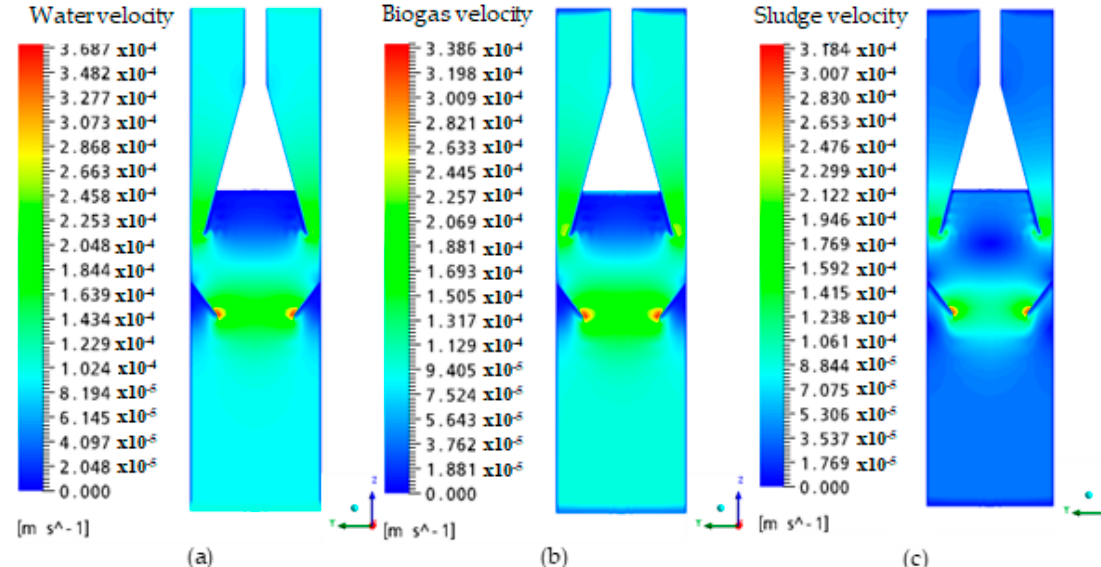
Figure 5. Velocity field in the UASB reactor, with deflector inclination downwards, for phases: ( a ) water, ( b ) biogas, and ( c ) sludge.